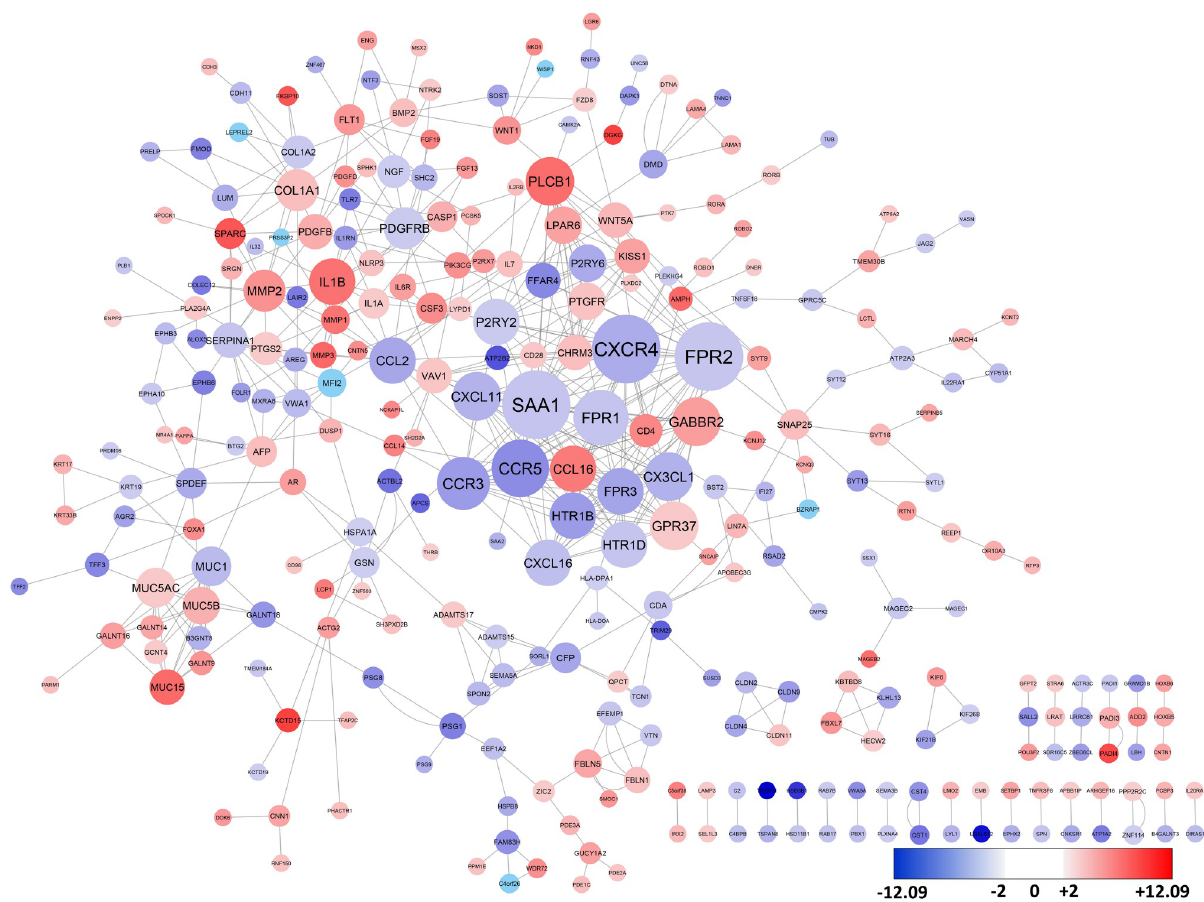
Fig 4. The Constructed PPI network with the DEGs for lung metastasis from breast cancer. Disconnected nodes were hidden in the network. Key hub nodes were highlighted with a larger size based on the degree of connectivity. Red and blue circles indicate up-regulated and down-regulated genes,